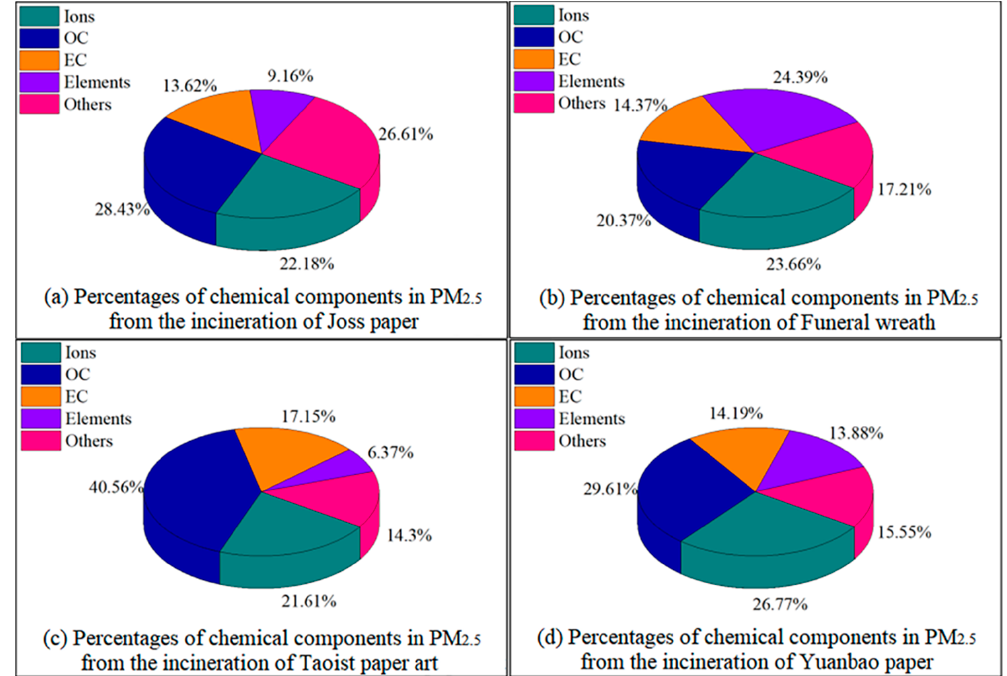
Figure 7. Percentages of chemical components in PM 2.5 generated from the incineration of sacrificial offerings: ( a ) Joss paper; ( b ) Funeral wreath; ( c ) Taoist paper art; (d) Yuanbao paper.